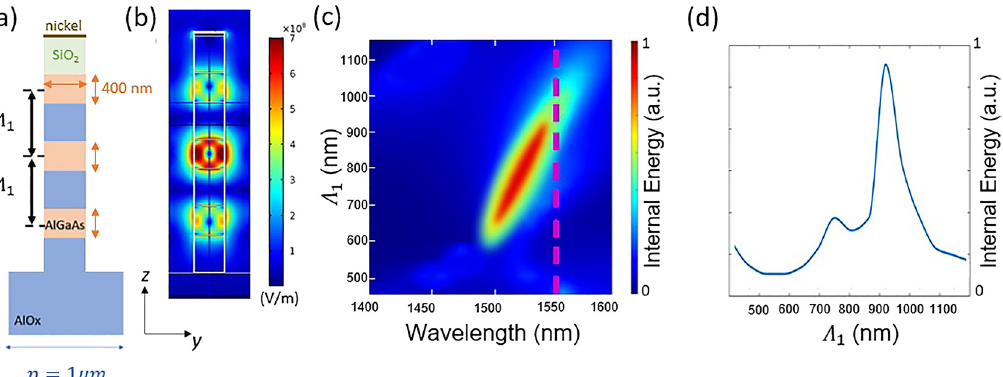
Figure 2: (a) Sketch of the proposed unitary cell with vertical spacing Λ 1 = 900 nm and in-plane period p = 1 μ m. Note that for the sake of coherence with the fabricated structure, the simulation includes additional cylinders of SiO 2 and nickel on the top and of AlOx at the bottom, eventhoughtheyareopticallyinactive(seeSectionS1oftheSupplementaryMaterial)(b)Electric- fi elddistributionforthetripletmetasurfaces in (a). The pump is a y -polarized plane wave with 1 GW/cm 2 intensity. (c) Internal energy inside the AlGaAs nanodisks vs. incident FF wavelength. (d) Internal energy vs. Λ 1 , for a pump wavelength λ = 1550